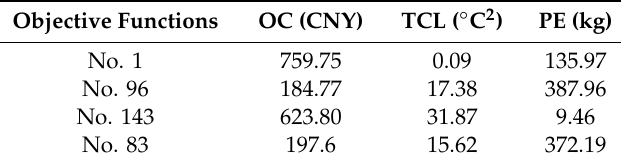
Table 12. Value of objective functions of di ff erent scheduling schemes for the typical day in summer.